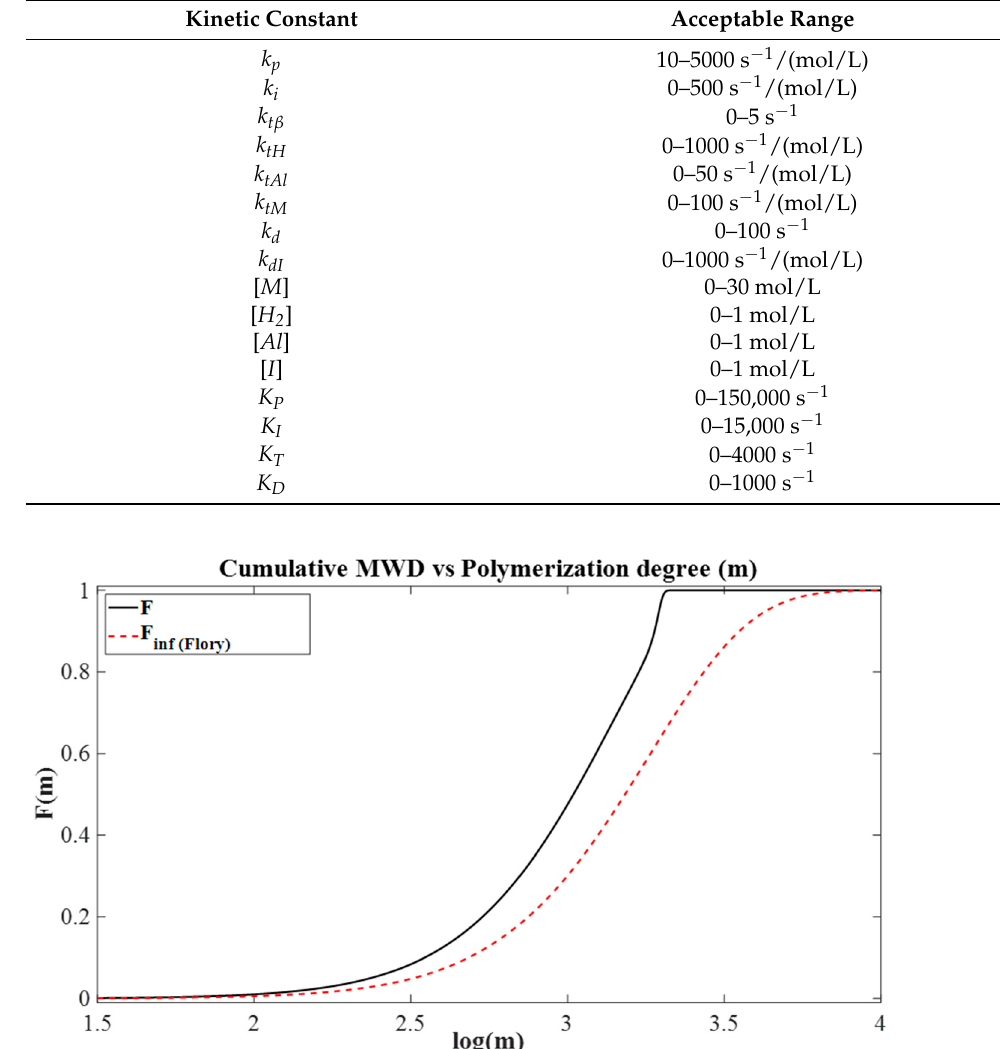
Figure 1. Cumulative molecular weight distribution according to Equations (33) and (34) ( K P = 100/s, K I = 1/s, K T = 0.1/s, K D = 0.01/s, t = 20 s). Table 1. Normal Range of Kinetic Constants.